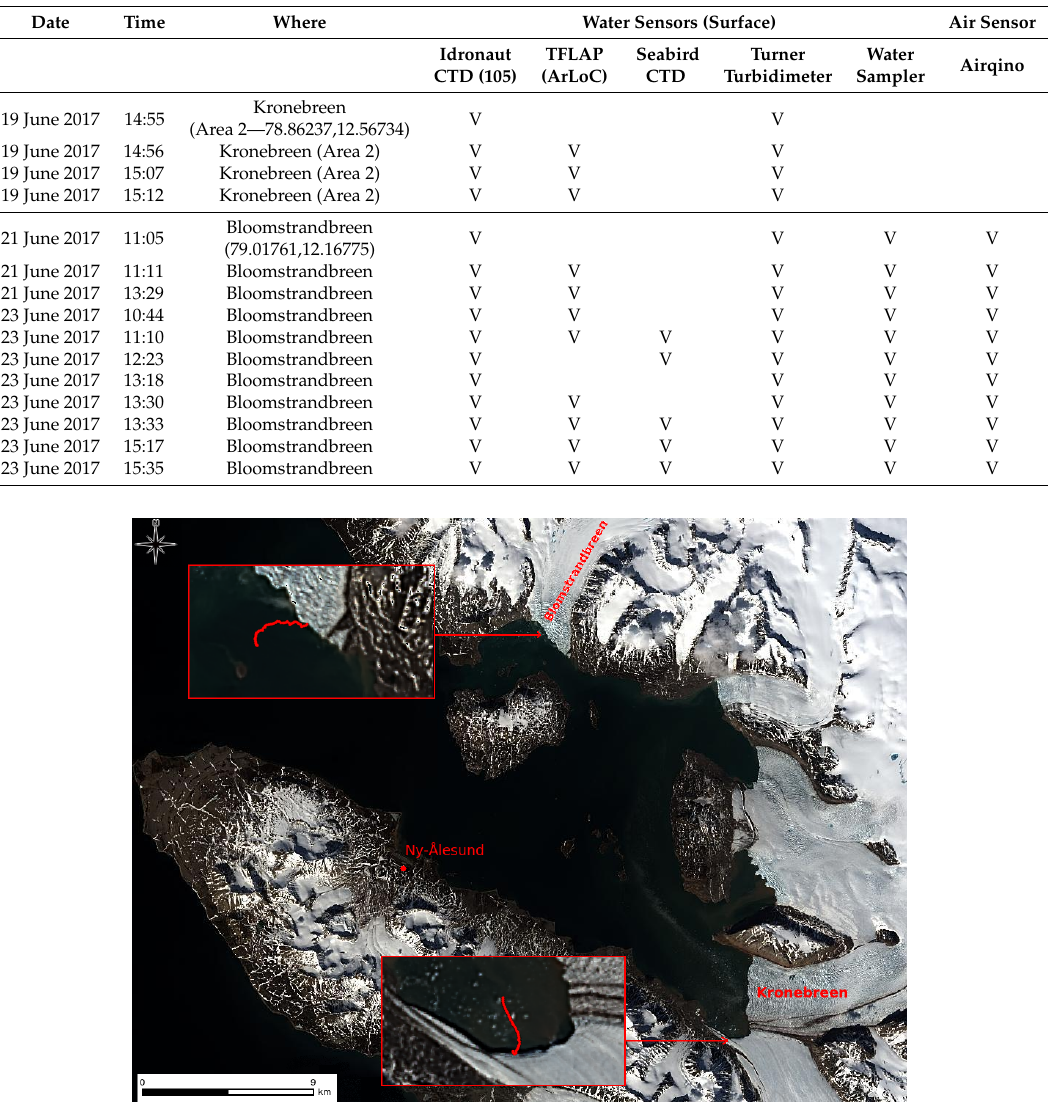
Figure 16. UVASS project: Map of the Kongsfjorden area obtained from the processing of Landsat8 data acquired in the same days in which the tests took place. In the boxes the GPS trajectories followed by PROTEUS during two missions are